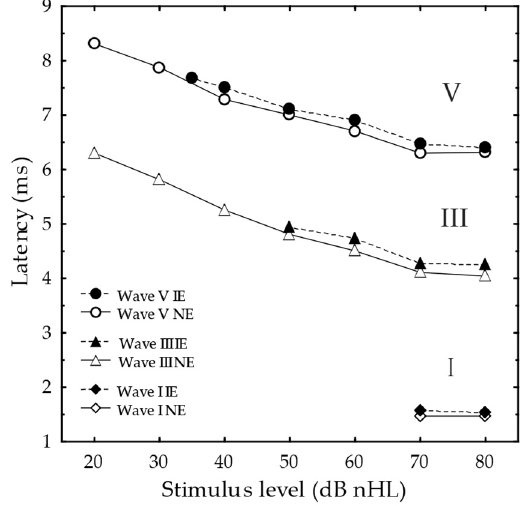
Figure 2. Mean Auditory brainstem response latency as a function of stimulus level (dB nHL) for wave V (circles), wave III (triangles) and wave I (rhombi) for the IE (filled) and the NE (open). The ns = 1, 6, 10, 9, 12, and 11 for wave I in the IE for 35, 40, 50, 60, 70, and 80 dB nHL, respectively, whereas the ns = 20, 16, 16, 13, 9, 20, and 9 in the NE for 20, 30, 40, 50, 60, 70, and 80 dB nHL, respectively. For wave III the ns = 7, 5, 11 and 10 in the IE for 50, 60, 70, and 80 dB nHL, respectively, whereas the ns = 11, 13, 14, 11, 9, 20, and 9 in the NE for 20, 30, 40, 50, 60, 70, and 80 dB nHL, respectively. The wave I ns = 8 and 7 for the IE and ns = 17 and 8 for the NE at 70 and 80 dB nHL,